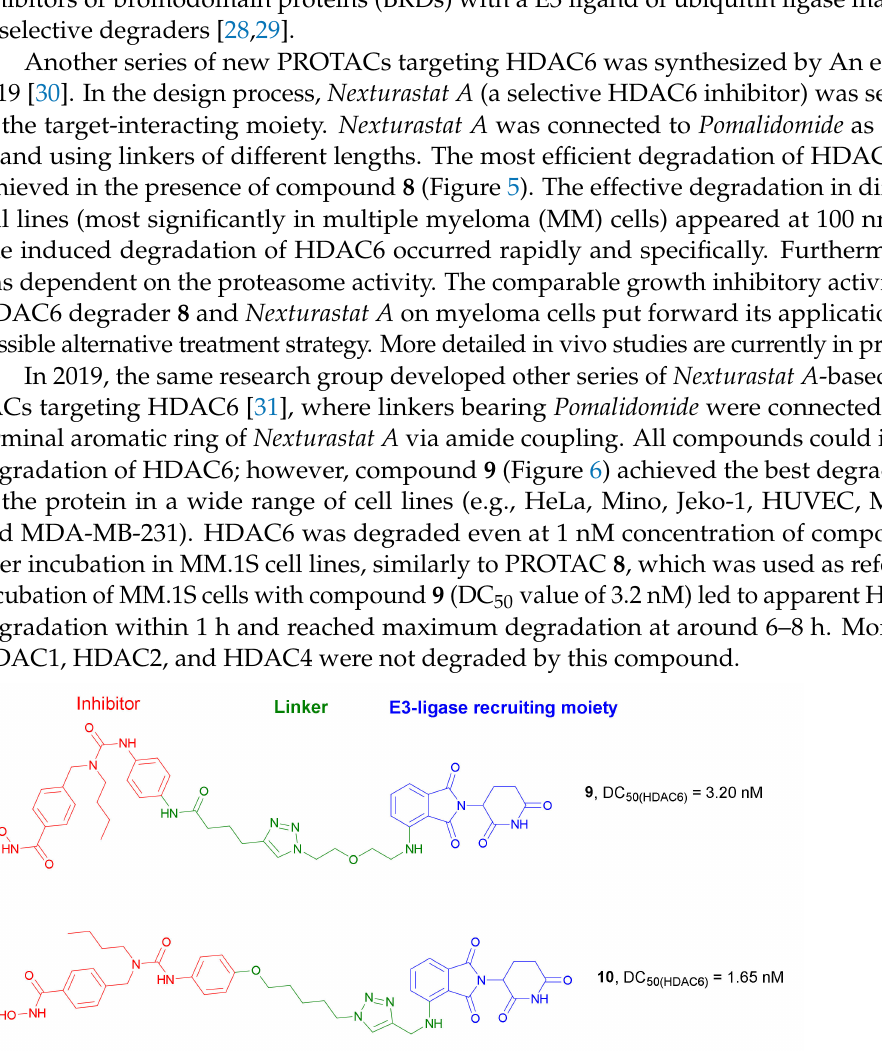
Figure 6. General structures of PROTACs 9 and 10